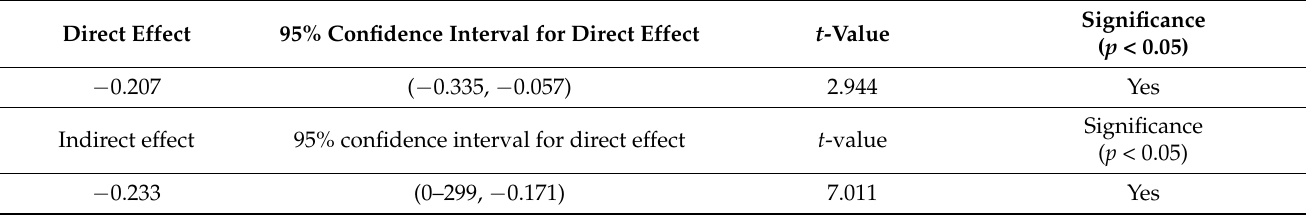
Table 3. Direct and indirect